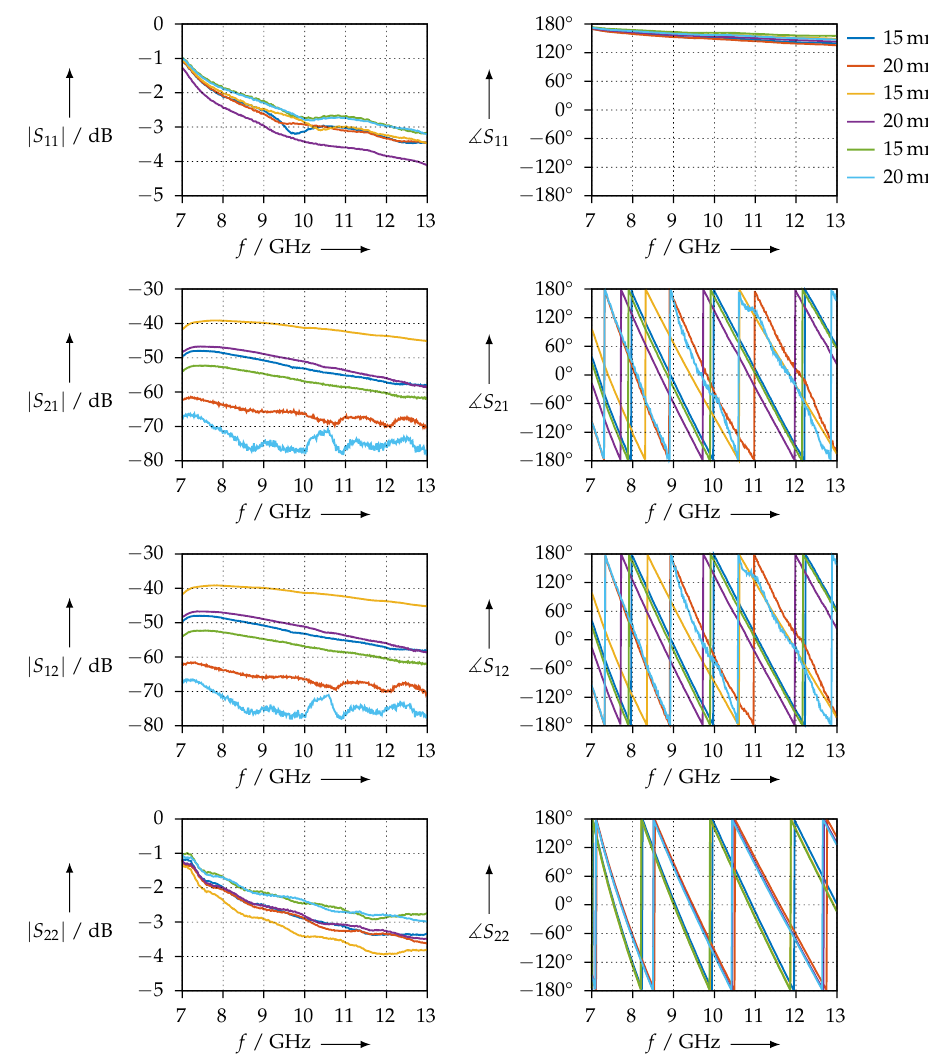
Figure 28. Magnitude and phase of the transmission and reflection S-parameters of the CDP material samples, measured in the WR90